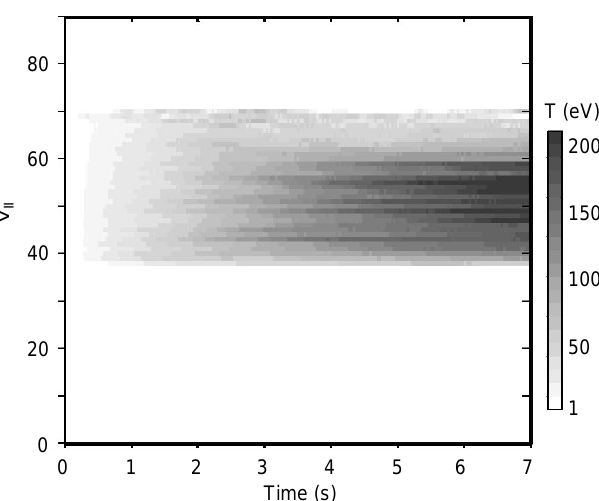
Fig. 6. Evolution of the perpendicular temperature at di(cid:128)erent parallel